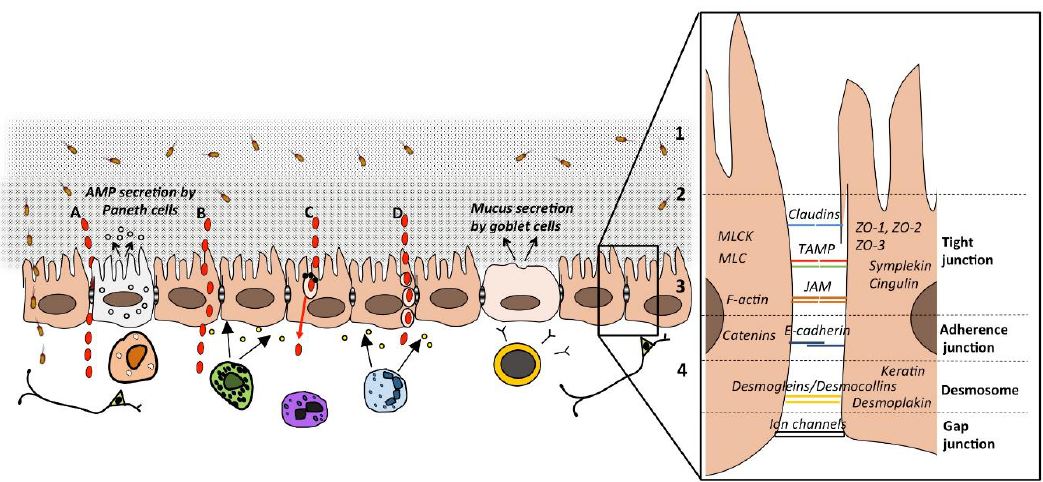
Figure 1. A schematic drawing of the intestinal barrier and passage routes across the epithelium. Solutes can pass the intestinal epithelium via either the ( A ) paracellular route (larger hydrophilic solutes); ( B ) transcellular route (small hydrophilic and lipophilic solutes) ( C ); transcellular route via aqueous pores (small hydrophilic solutes) or active carrier-mediated absorption (nutrients); or ( D ) endocytosis, followed by transcytosis and exocytosis (larger particles, peptides and proteins). The barrier constitutes of (1) the lumen, bacteria and antigens are degraded by biliary juices, gastric and pancreatic acids and the colonization of pathogens is inhibited by commensal bacteria producing antimicrobial substances; (2) the microclimate; unstirred water layer, glycocalyx, bacterial adhesion is prevented by mucus and IgA secretion; (3) the epithelial cells; luminal content is transported while noxious stimuli is impeded by chloride secretion and production of antimicrobial peptides (AMP), junctional complexes between the cells regulate permeability, for details see right panel; (4) the lamina propria; immunoglobulins and cytokines are secreted from cells of both the innate and acquired immunity with direct or indirect effects on permeability, interactions with the endocrine and enteric nervous system. TAMP: tight junction-associated-MARVEL proteins including occludin, tricellulin and Marvel D3; JAM: junctional adhesion molecule; MLC: myosin light chain; MLCK: MLC of myosin II kinase.